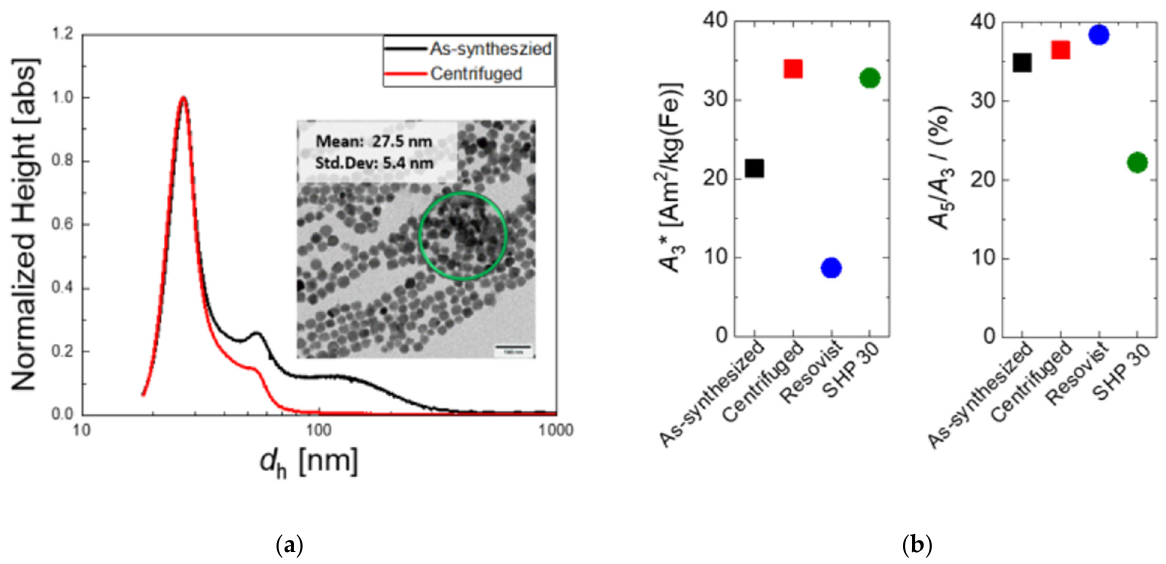
Figure 1. ( a ) Particle fractionation by centrifugation (prior to BSA-coating): Hydrodynamic size distribution measured by DCS of as-synthesized (black line) and centrifuged (red line) MNP, where the broad shoulder from 70 up to 300 nm is significantly reduced. Inset: Representative TEM image of as-synthesized MNP with areas of aggregated particles marked by the green circle (scale bar 100 nm). ( b ) MPS parameters A 3 * and A 5 /A 3 measured at B ex = 25 mT for as-synthesized (black symbols) and centrifuged MNP (red symbols) showing the signal increase gained by particle fractionation. Included are the corresponding MPS parameters of the two commercial systems Resovist (blue symbols) and SHP-30 (green symbols).